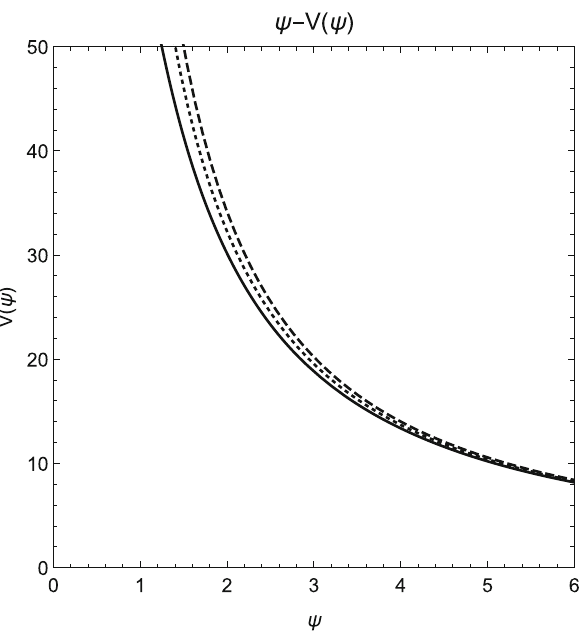
Fig. 1 Qualitative behaviour of the scalar field potential V (ψ) for various values of the free parameters ψ 1 , ψ 2 . Solid line is for (cid:9) (cid:10) (ψ ,ψ , 1 1 ) = , dotted line is for (ψ 1 ,ψ 2 ) = 1 2 (cid:9) (cid:10) 2 2 , − 1 1 for (ψ 1 ,ψ 2 ) = . From the plots we observe that the potential 2 2 behaves like a power-law function. The plots are for θ 0 = 1 , ζ = 1 and c θ = 6 where the power-law solution describes an accelerated